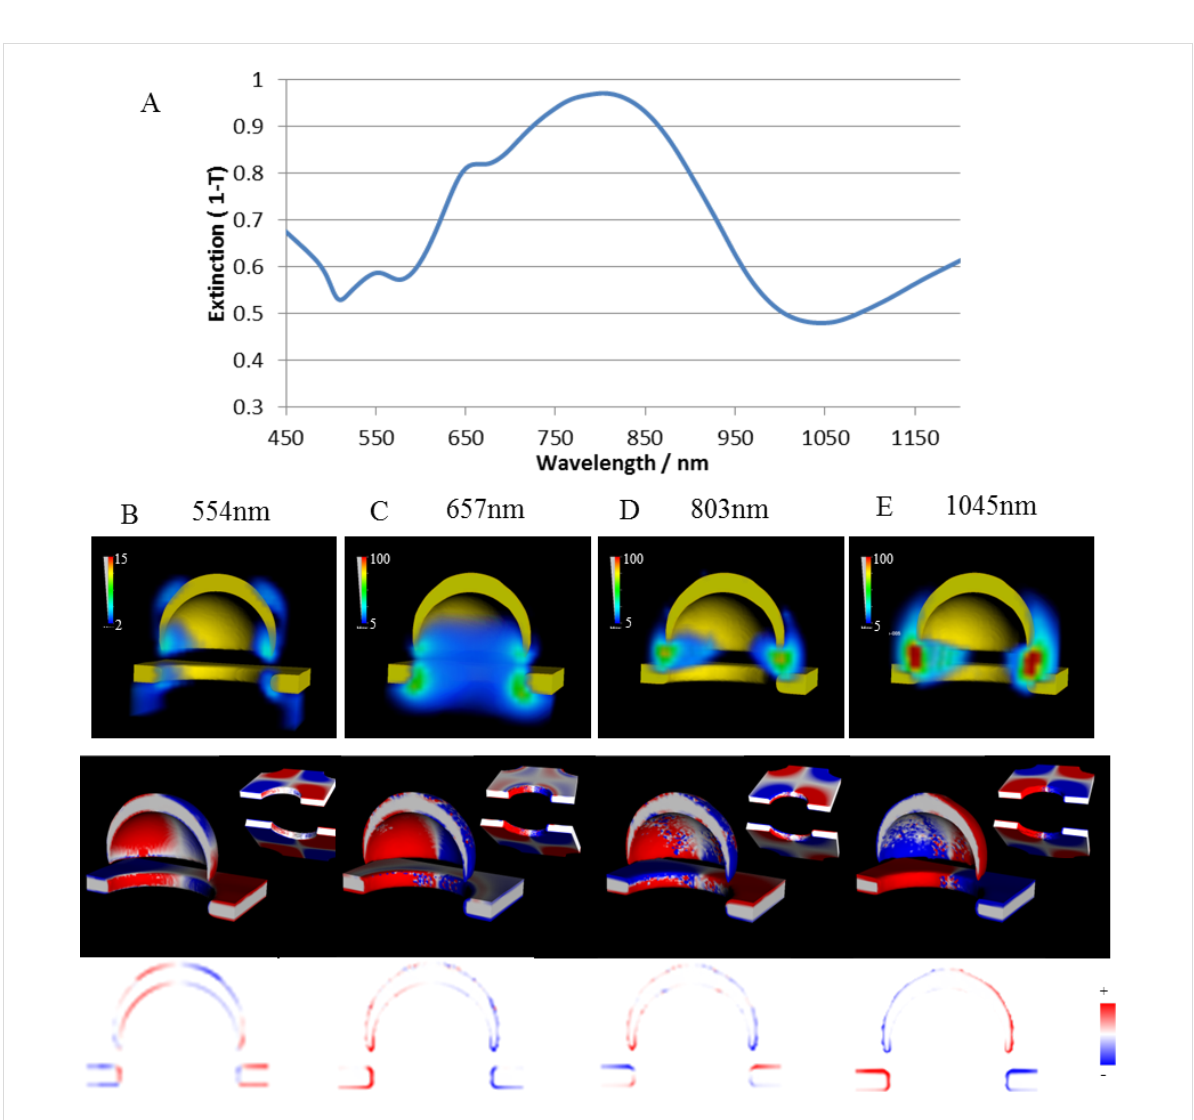
Figure 7: A) Simulated extinction spectra of a 20 nm thick cap/hole structure (diameter 110 nm). Underneath the E-field intensity (| E | 2 /| E 0 | 2 ) and charge density plots for the peaks at 554 nm (B), 657 nm (C), 803 nm (D) and dip at 1045 nm (E) are shown. In the 3D charge density plots insets of the hole parts without the cap are shown from the bottom and the top for easier presentation of the charges at the gold film surface. The cap was still taken into account for these plots. The direction of the light propagation is normal to the surface and the polarization horizontal in the figure plane.